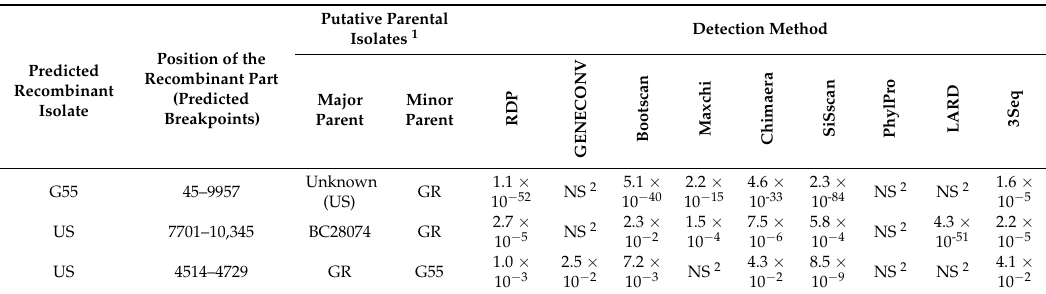
Table 3. Recombination analysis of BcLRaV-1 isolates.